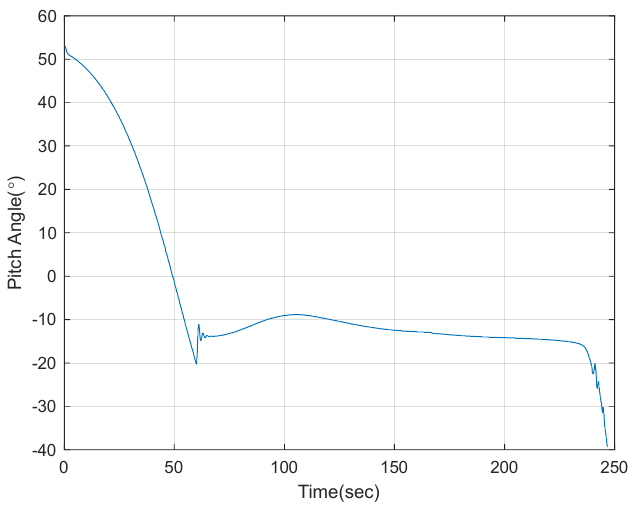
Figure 18. Pitch Angle.